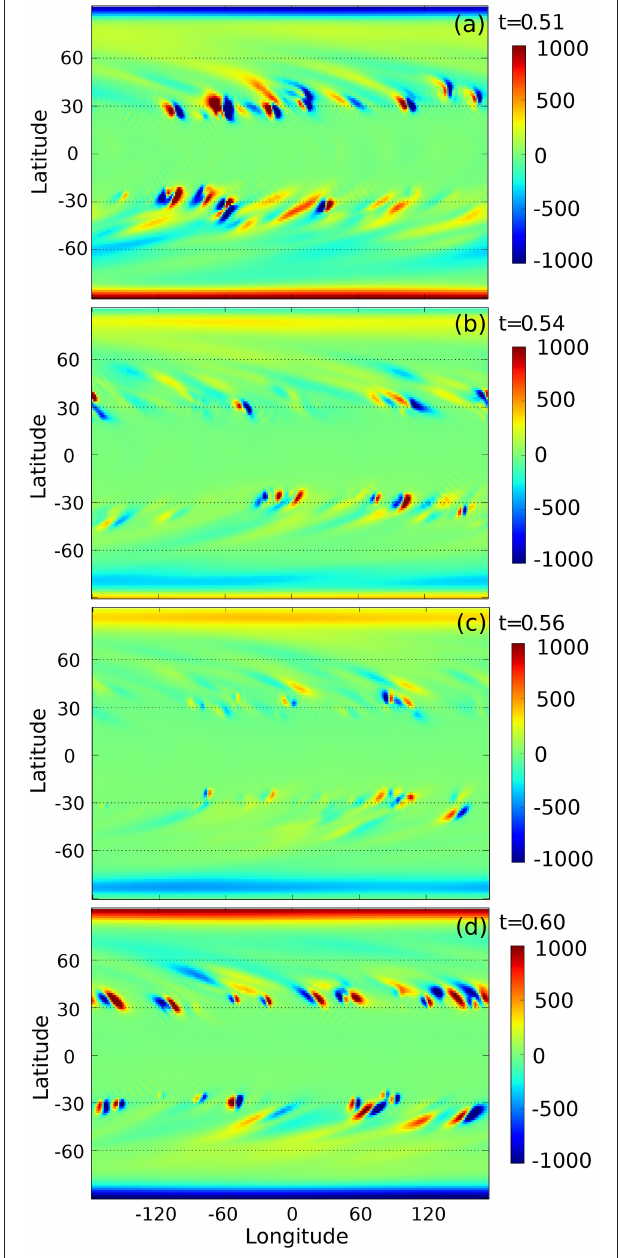
FIGURE 5 | Snapshots of the non-dimensional radial magnetic field ( B r ) at the surface showing (A) the large-scale polar field along with tilted BMRs, (B) reversal of the polar field, (C) sunspot minimum, and (D) the polar field and the BMRs after the polarity reversals. Here, a unit magnetic field corresponds to 20 Gauss.